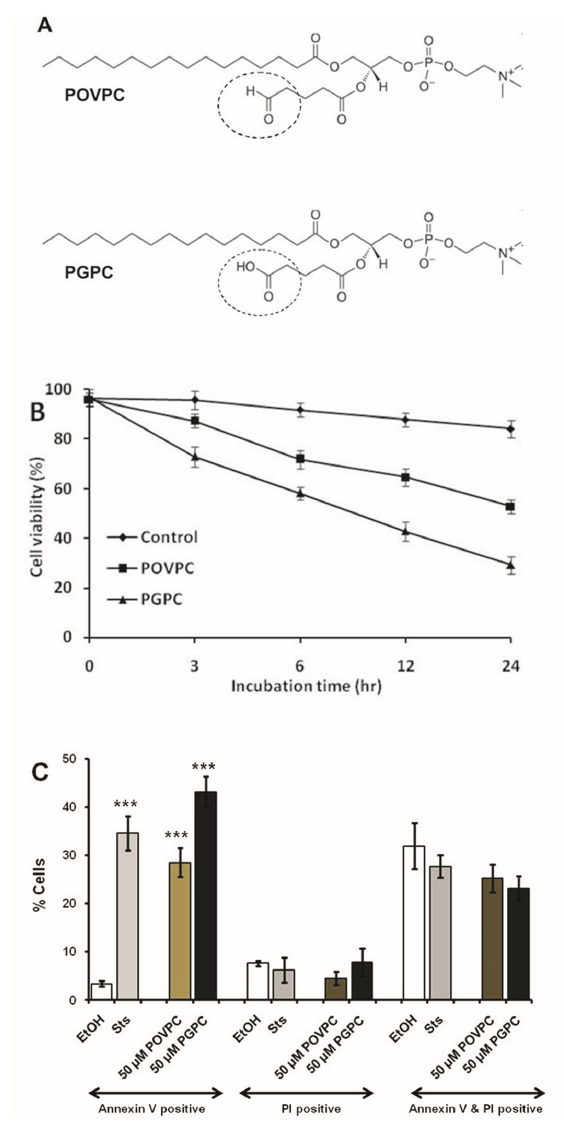
Figure 1. The oxidized phospholipids POVPC and PGPC are cytotoxic and induce apoptosis. (A) Chemical structures of POVPC and PGPC. Dotted circle represents the functional group at sn-2 position. (B) RAW 264.7 cells were incubated with 50 µM POVPC and PGPC for indicated periods. Control cells were treated with 1% ethanol. Cell viability was determined by Vybrant® MTT assay kit. Results are expressed as a percentage of viable cell number in treated cells compared with that of untreated control cells. Data are means ± S.D., n = 8 in each group. (C) Cells were incubated with the stated concentrations of POVPC and PGPC for 4 h. The cells were analyzed for Alexa Fluor -annexin V and propidium iodide 488 fluorescence staining by Flow cytometry as described under “Experimental Procedures”. Results are represented as means ± S.D. Probabilities compared to control were determined by Student’s t-test (two-tailed, unpaired); ***p < 0.001,(n = 8 in each group). doi: